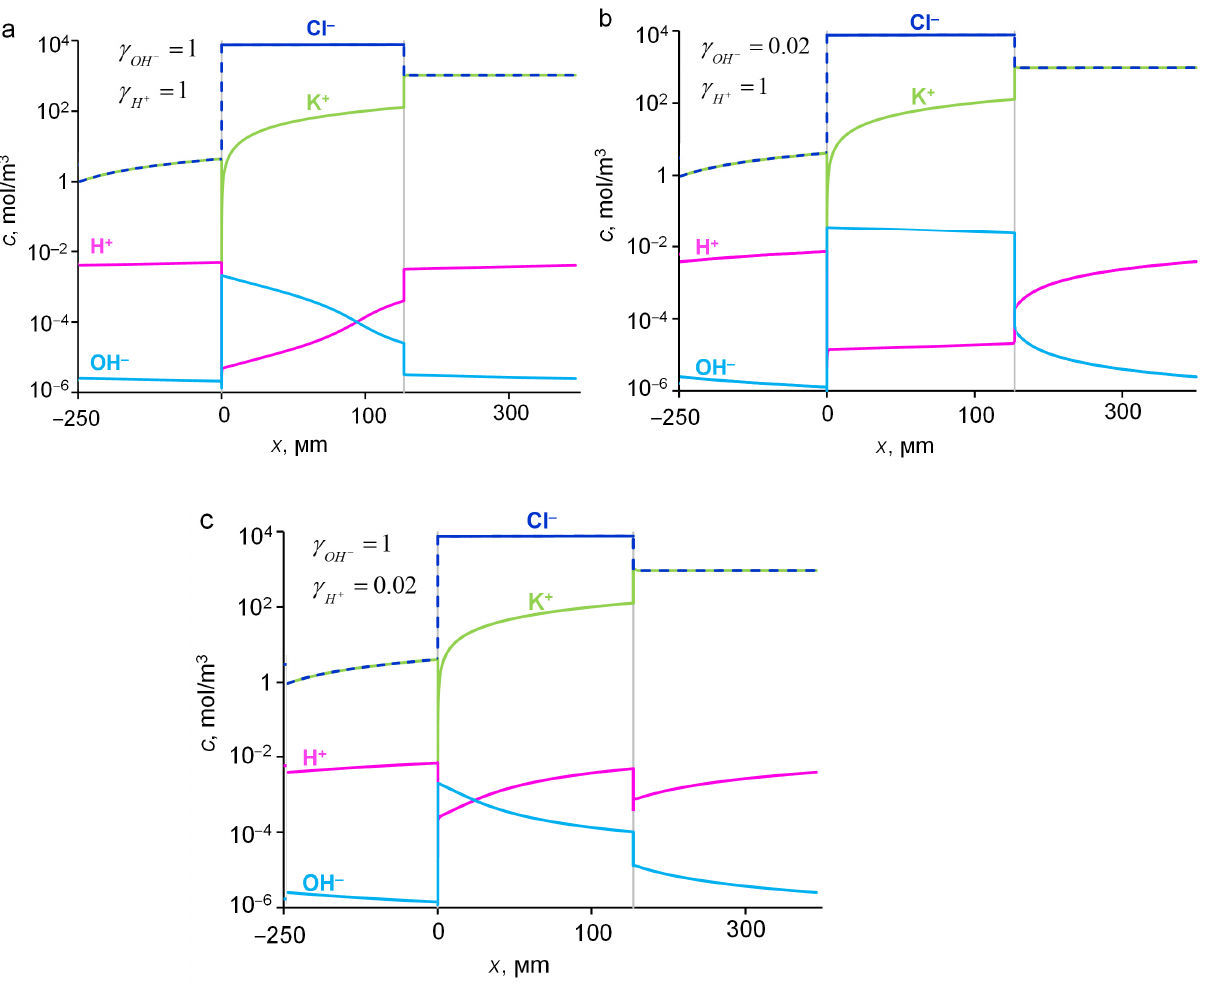
Figure 6. Distribution of ion concentrations in the system under study at different γ (indicated in the plots) at 1 M of feed electrolyte KCl solution: 1 and 1 ( a ), 0.02 and 1 ( b ), 1 and 0.02 ( c ), respectively. Simulation with the input parameters presented in Table 1.